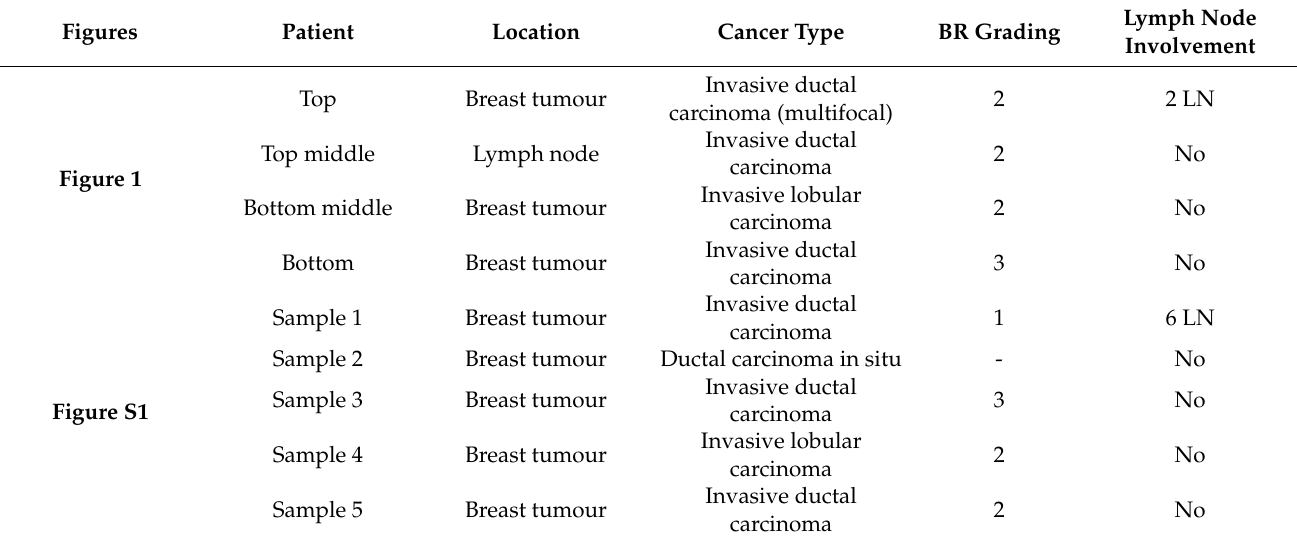
Table 1. Patient details from paraffin-embedded tumour